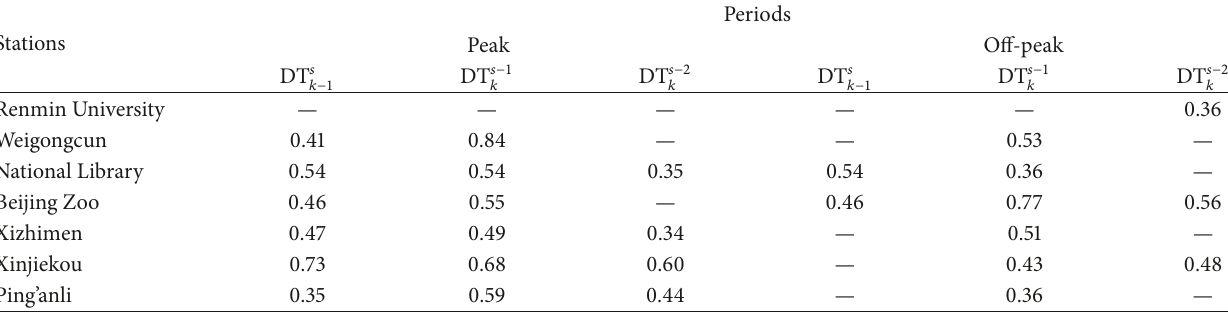
Table 5: The correlations between the input variables and the dwell time.